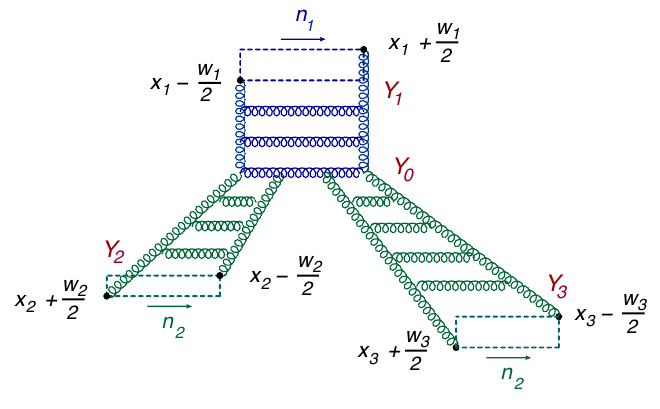
Figure 17 . Triple BFKL evolution at n 2 = n 3 with BK vertex at the rapidity Y 0